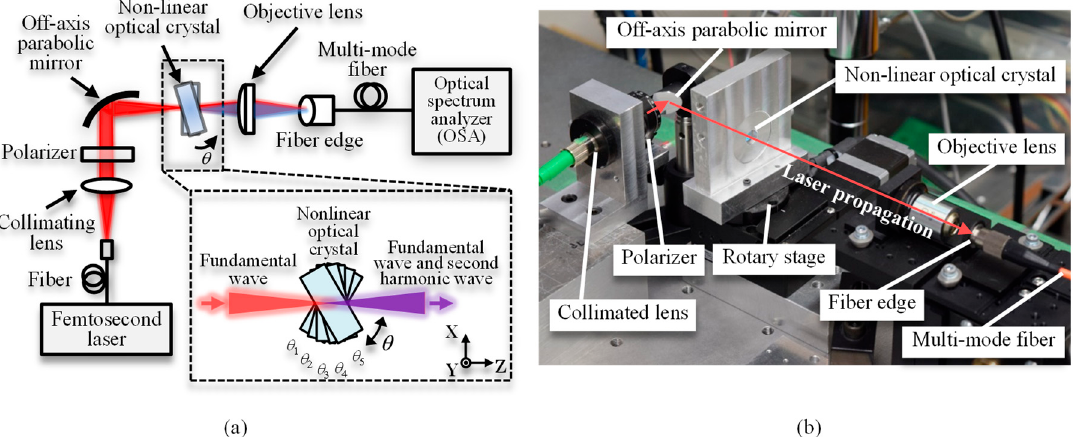
Figure 5. ( a ) Schematic of the experimental setup to observe FW and SHG phenomena using an off-axis parabolic mirror for beam focusing; ( b ) a photograph of the experimental setup.